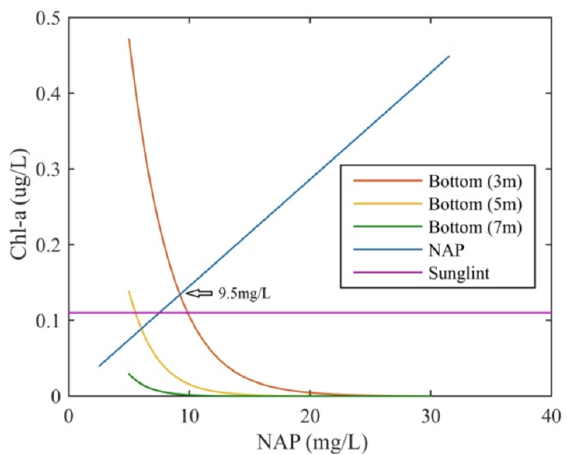
Figure 28. Errors caused by sun glint, bottom reflectance, and NAP versus the concentration of the NAP. The NAP is the primary source of error when NAP > 9.5mg/L.